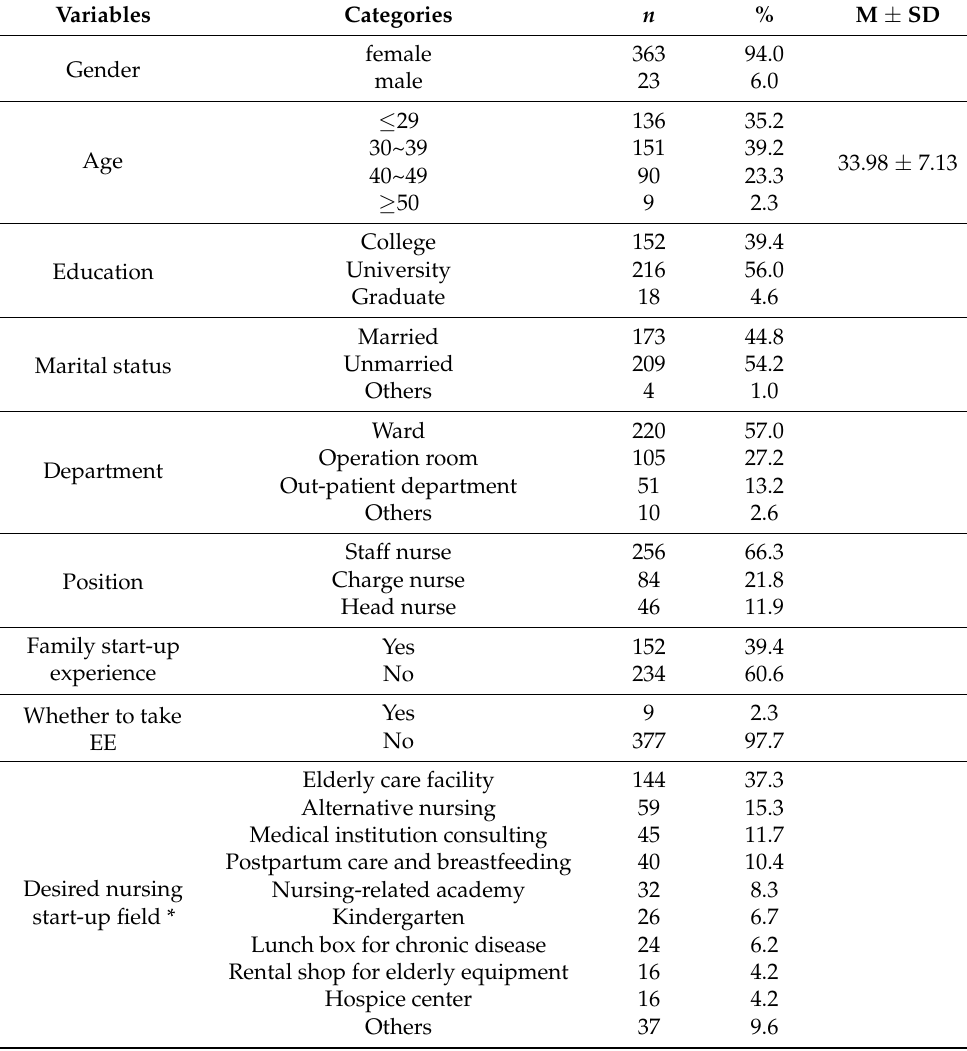
Table 2. General characteristics ( n =